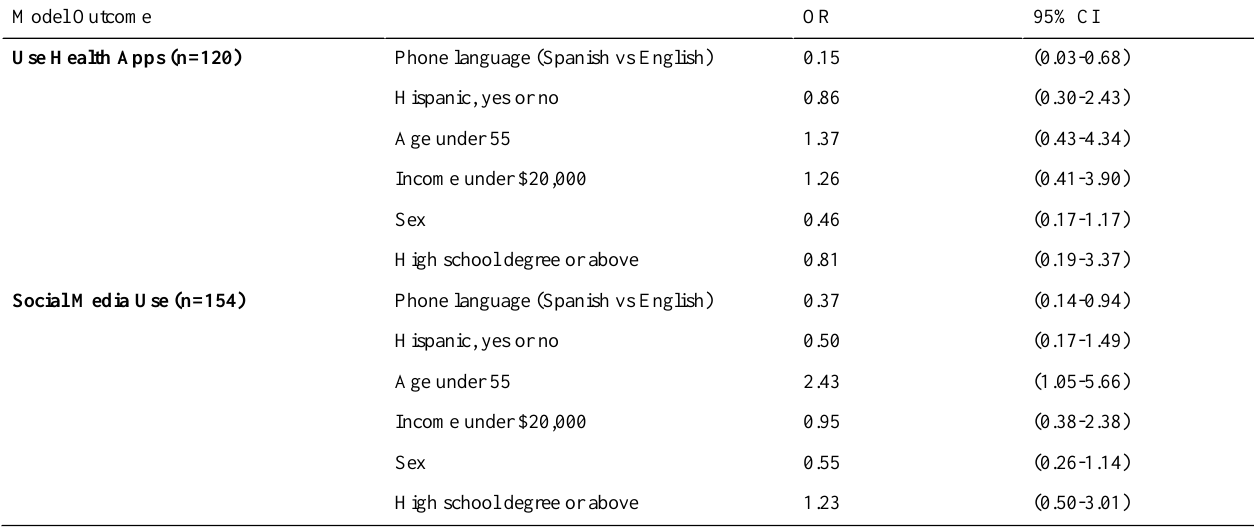
Table 4. Multivariate models to predict health app and social media use among participants with mobile